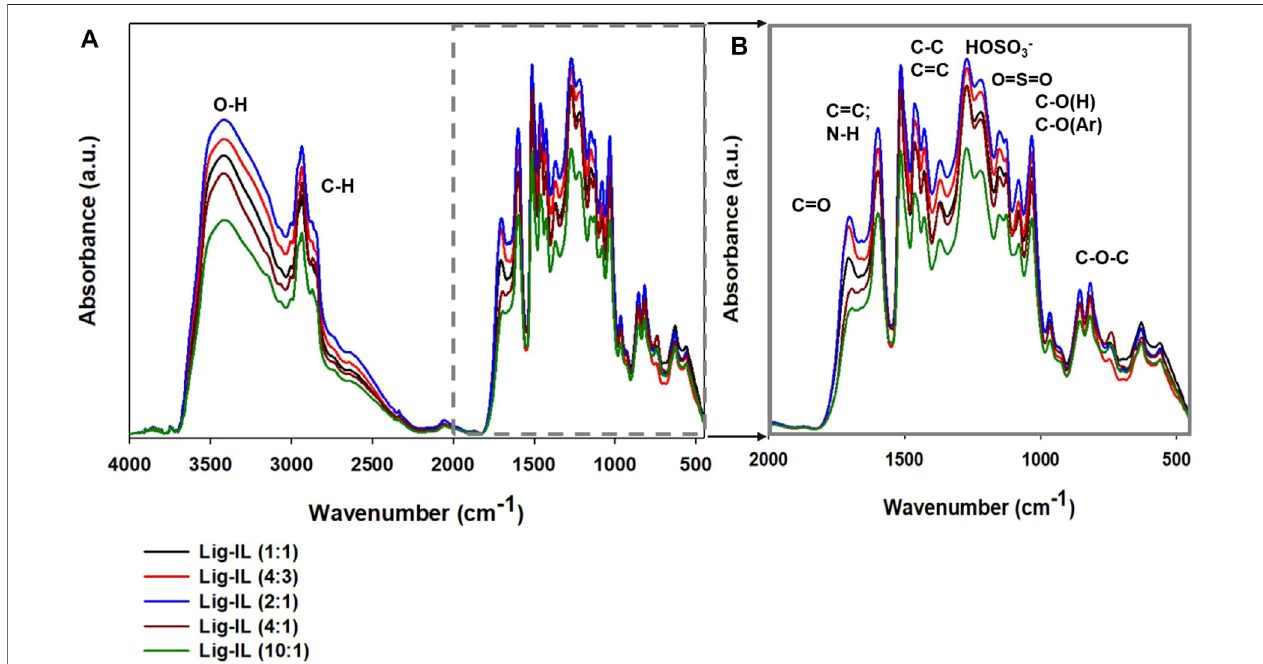
FIGURE 4 | FTIR spectra of all prepared materials (A, B) , shown in two wavenumber ranges.